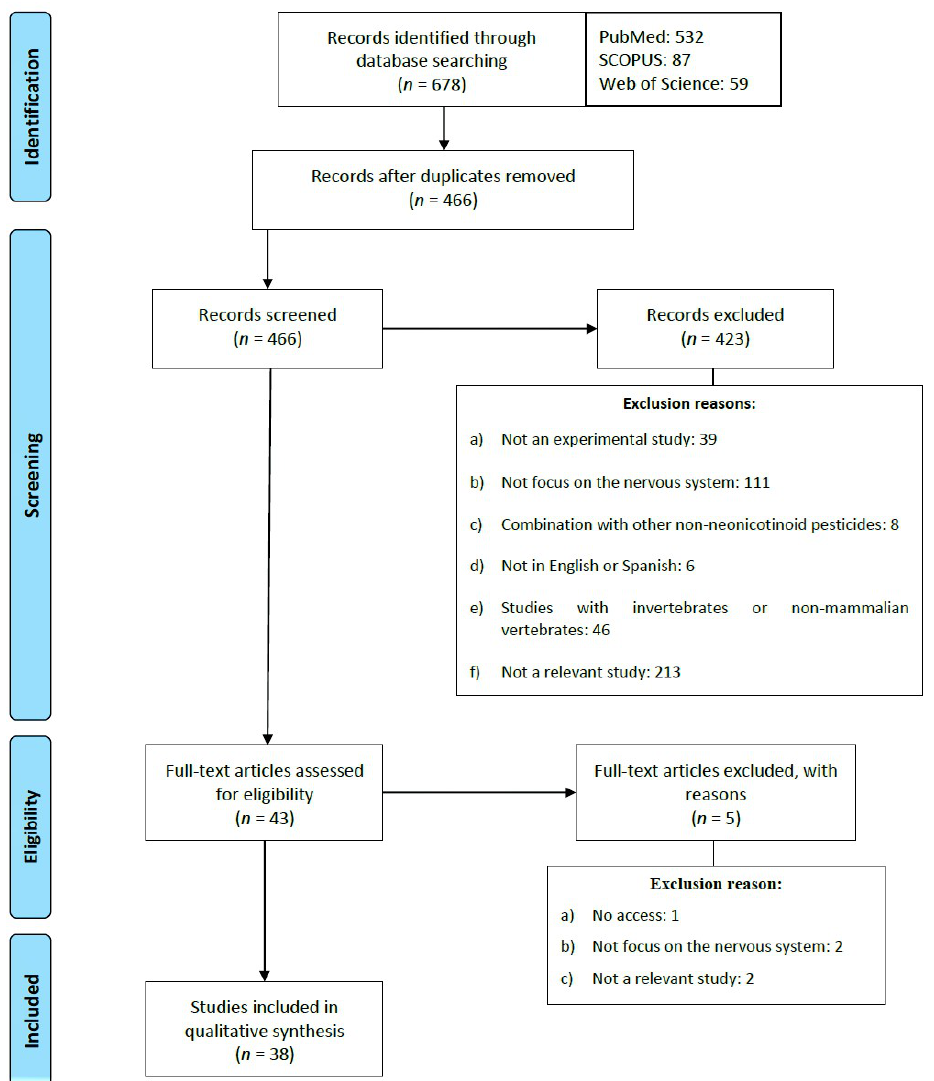
Figure 2. Flow diagram of the systematic search process.